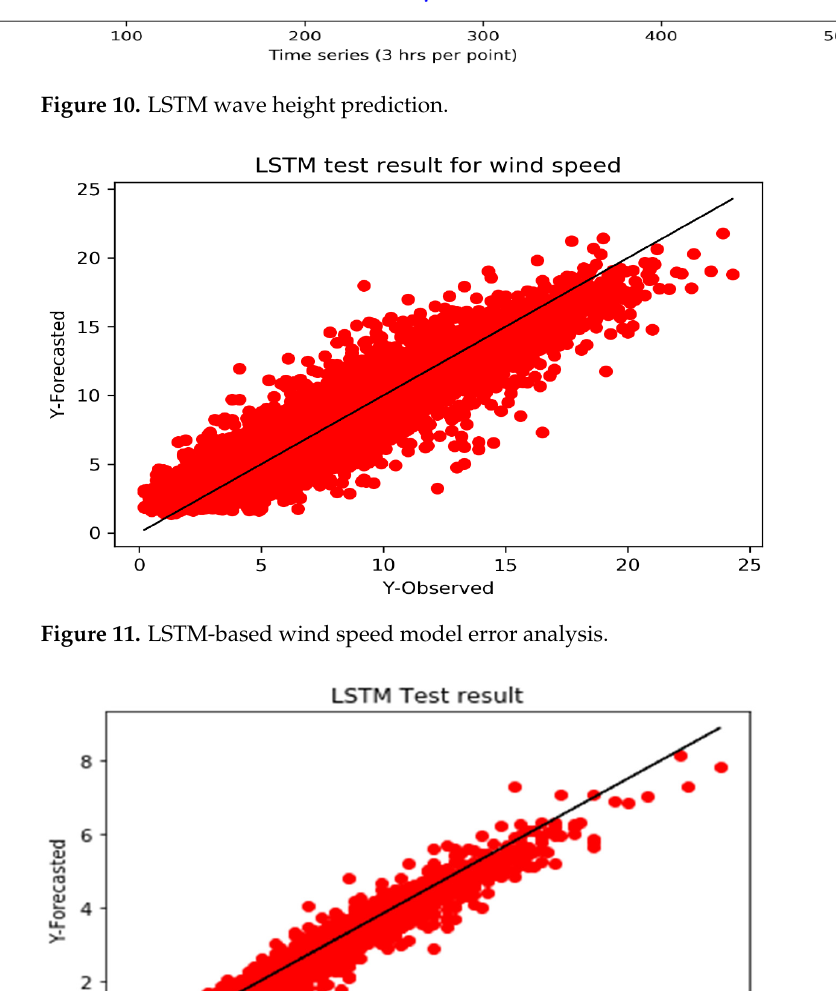
Figure 10. LSTM wave height prediction.